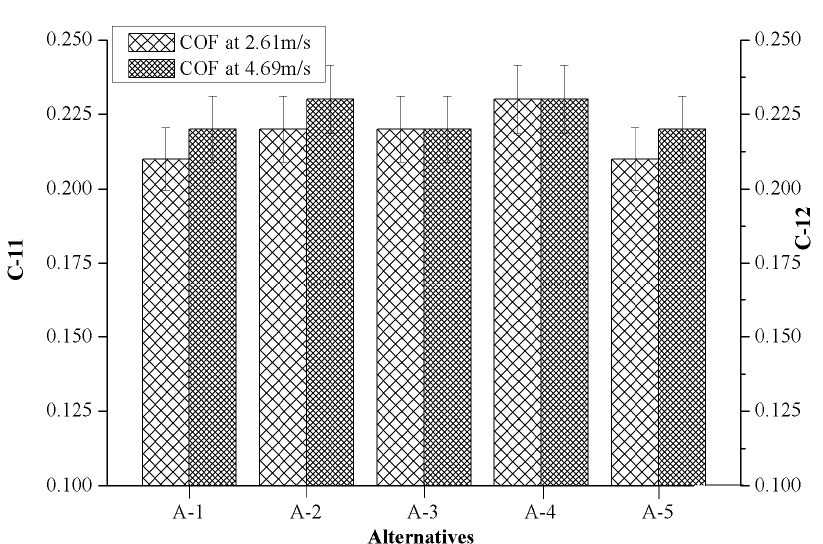
Figure 8. Evolution of criterion-11 and criterion-12 with the values of alternatives.